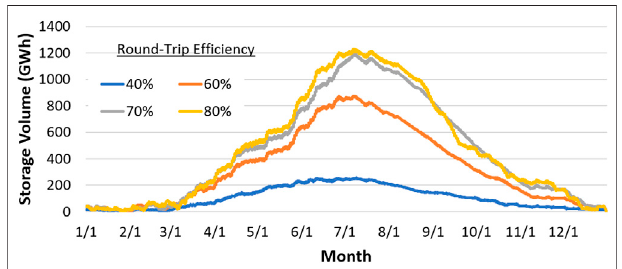
FIGURE 10 | 12-month fi ll pro fi le for a 2,000 MW energy storage resource with 40%, 60%, 70%, and 80% round-trip ef fi ciencies and 9-day (0.43 TWh), 24-day (1.15 TWh), 30-day (1.44 TWh), and 32-day (1.54 TWh) discharging, respectively.